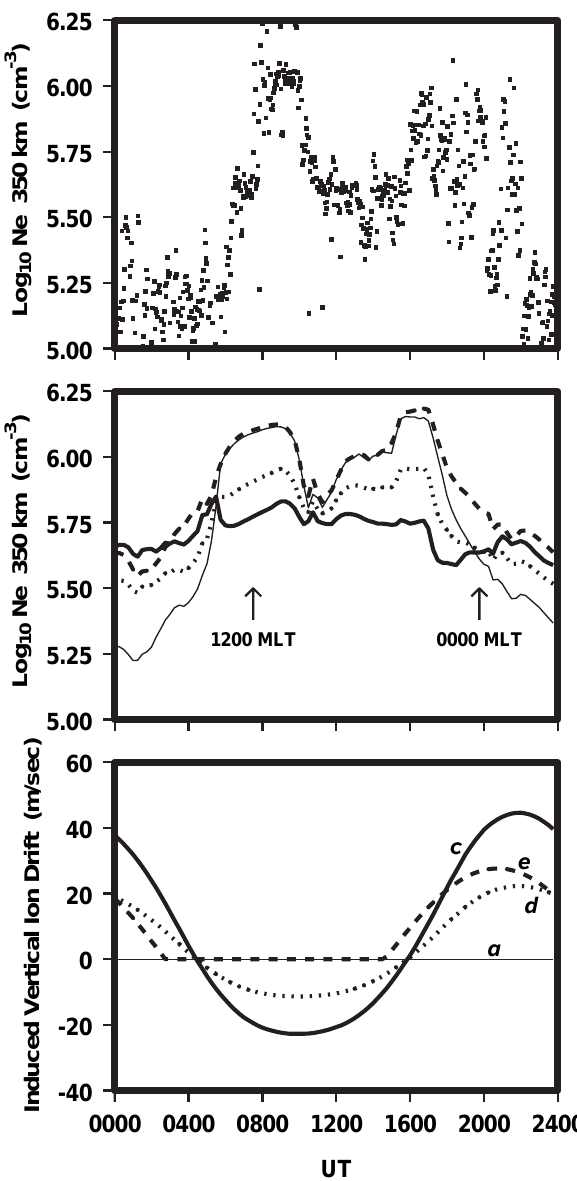
Fig. 5. Comparisons of electron densities at 350km for day 292. ESR observed N e is shown in the top panel, with four TDIM simu- lation results in the middle panel, and the induced vertical ion drifts for the four TDIM simulations in the bottom panel. The letters (a, c, d, e) correspond to the labels in Fig. 4: (a) no wind, (c) standard HWM, (d) half HWM, and (e) for simplified